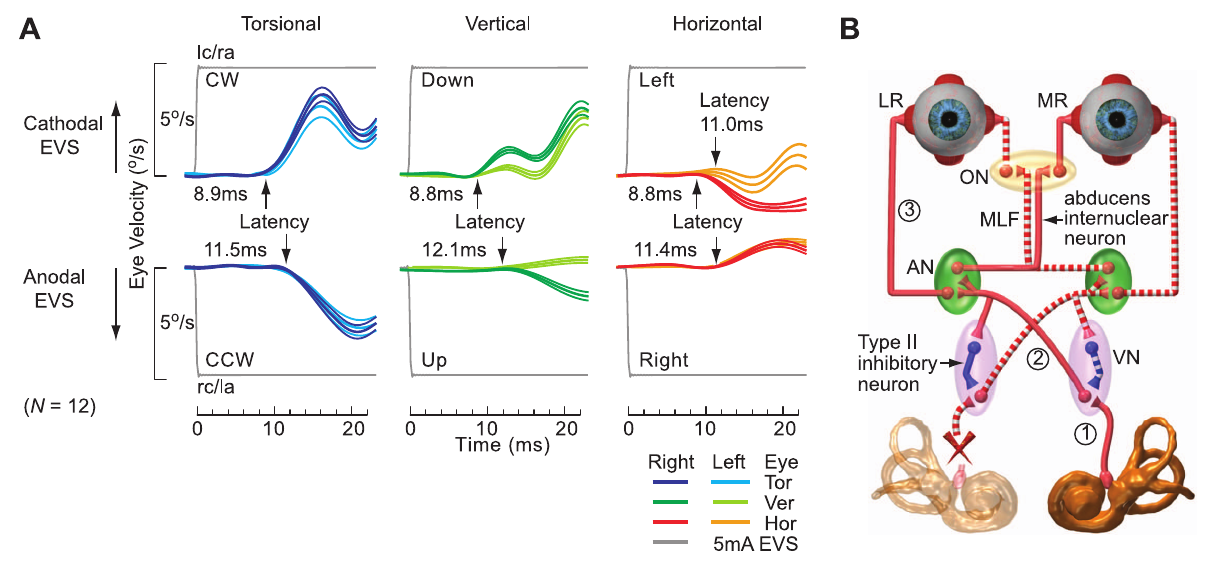
Figure 3. Latency of the eVOR after UVD. (A) Excitatory and inhibitory eVOR latencies of binocular torsional, vertical and horizontal eVOR to 5.0 mA lc/ra cathodal EVS and rc/la anodal EVS from grouped as right UVDs with functioning left ears ( N =12, group means 6 SEM) showing their mean latencies. (B) Schematic depicting the excitatory ( solid red line ) and inhibitory ( dashed red line ) horizontal semicircular canal pathways showing the 3-neuron reflex arc comprising 1 : vestibular nerve; 2 : vestibulo-ocular secondary neuron; 3 : abducens motorneuron. LR: lateral rectus muscle; MR: medial rectus muscle; ON: oculomotor nucleus; AN: abducens nucleus; VN: vestibular nucleus; MLF: medial longitudinal fasciculus. Equivalent 3- neuron reflex arcs also exist for the vertical semicircular canal pathways.